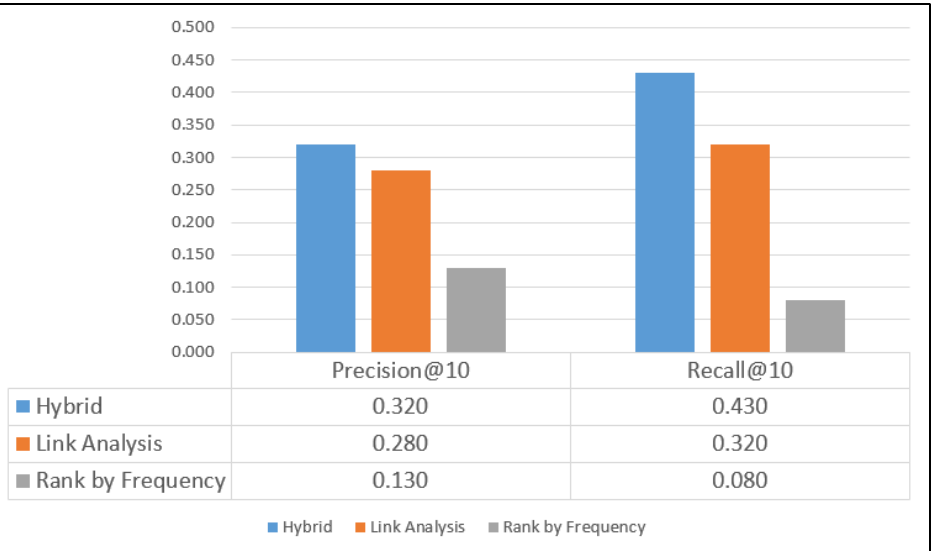
Figure 9. Results for the GeoLife dataset.